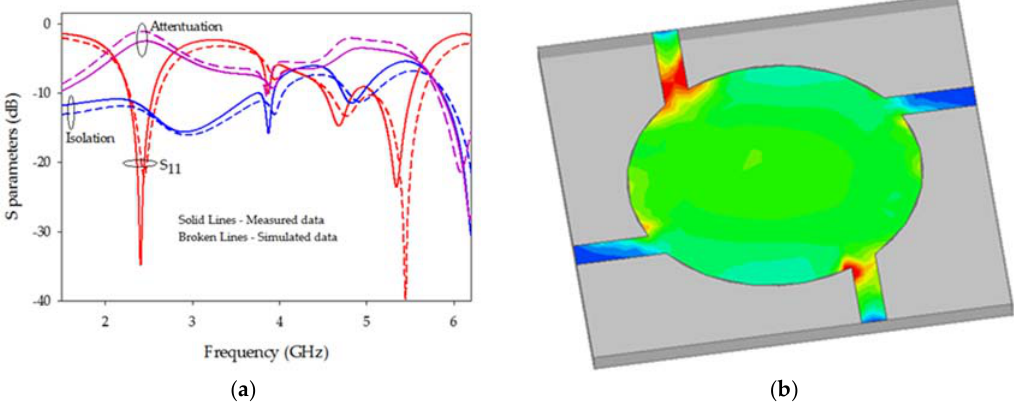
Figure 3. ( a ) Variation of S parameters with frequency for a CPC; ( b ) Current distribution of CPC at 2.45 GHz.